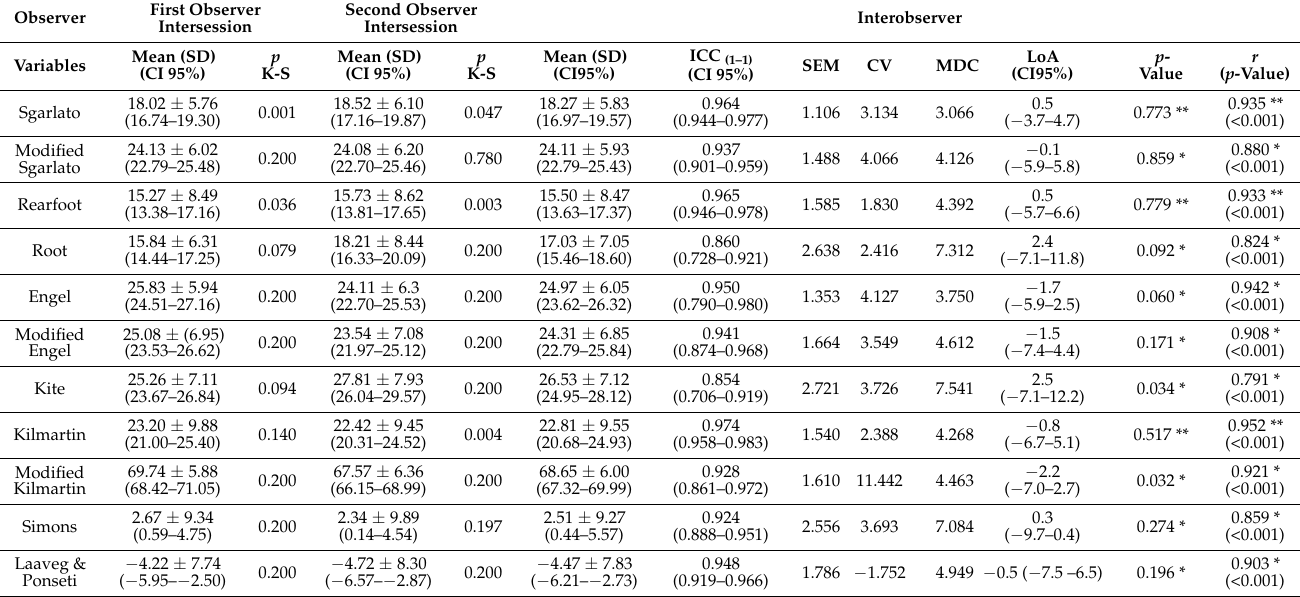
Table 4. Analysis of the reliability of metatarsus adductus angle measurements between